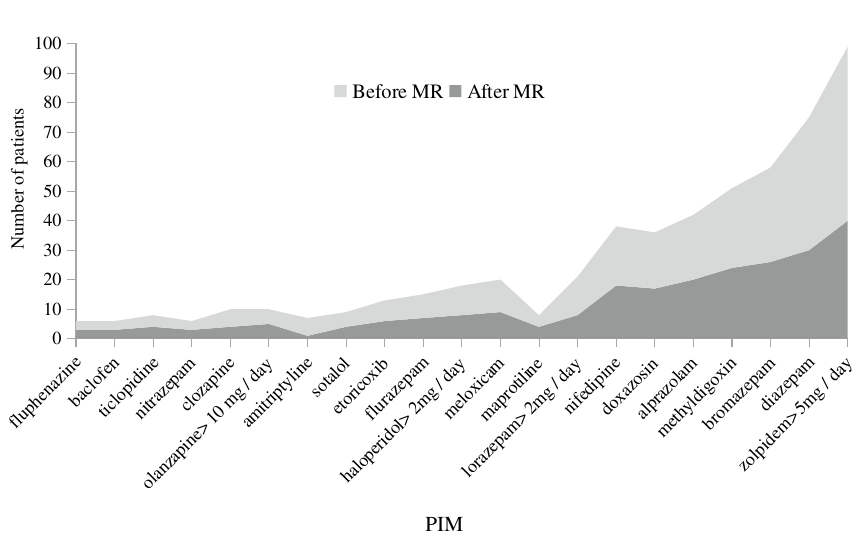
Table 2. Proposed and accepted clinical pharmacist interventions by psychotropic group.